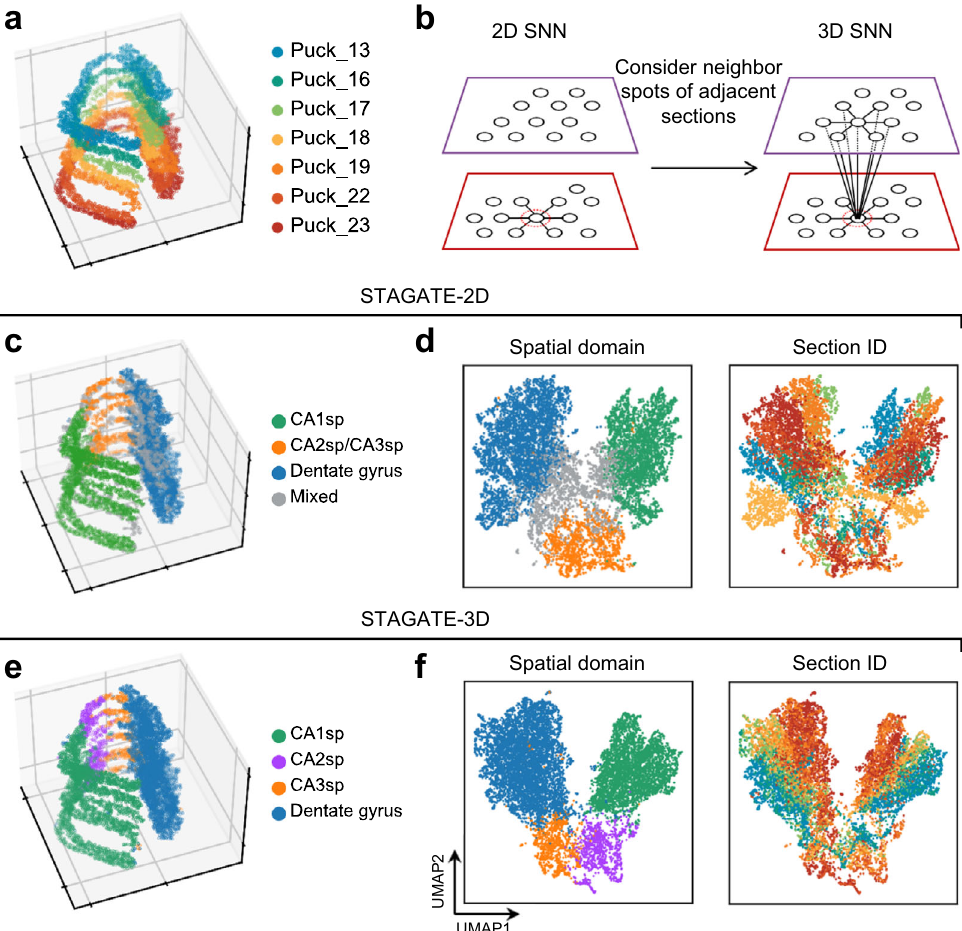
Fig. 7 STAGATE can alleviate the batch effect between consecutive sections by incorporating a 3D spatial network. a Visualization of the 3D hippocampal volume stacked by seven aligned consecutive sections pro fi led by Slide-seq. b The 3D SNN is a combination of the 2D SNN within each section and the spatial network between consecutive sections. c Cluster assignments generated by STAGATE-2D with the 2D SNN. d The UMAP plots generated by STAGATE-2D embeddings. The spots are colored by the identi fi ed spatial domains (left) and the section IDs (right) respectively. e Cluster assignments generated by STAGATE-3D with the 3D SNN. f The UMAP plots generated by STAGATE-3D embeddings. The spots are colored by the identi fi ed spatial domains (left) and the section IDs (right)